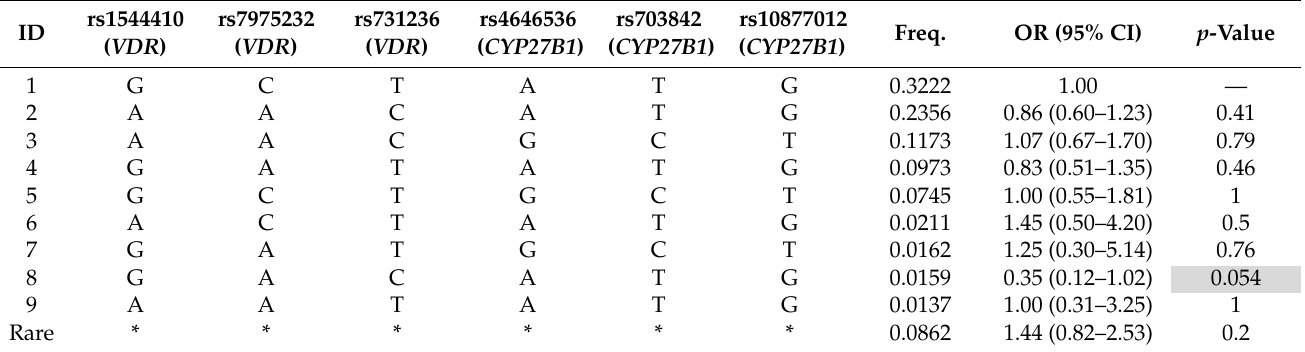
Table 4. Influence of haplotypes formed by 6 SNPs located on Chromosome 12 on risk of